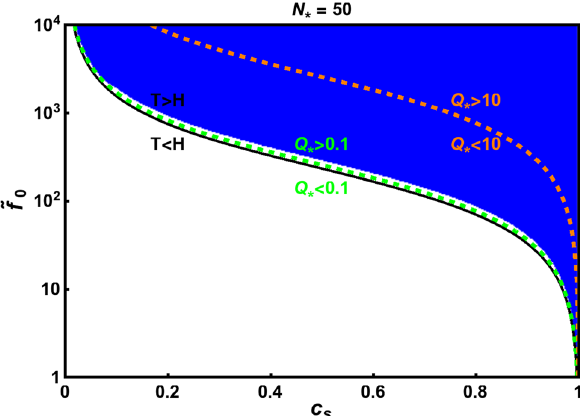
Fig. 3 The parameter space of ˜ f 0 − c s for which our warm DBI infla- tionary model with N ∗ = 50 is compatible with the 68% CL joint region of Planck 2015 TT, TE, EE + low P data [12] in r − n s plane. The dashed green and orange curves separate the weak ( Q ∗ = 0 . 1) and